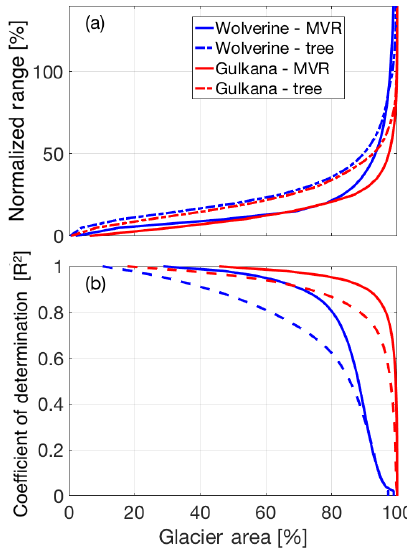
Figure 12. Interannual variability of the SWE accumulation pattern as a function of cumulative glacier area, shown as (a) normalized range and (b) and R 2 . Solid lines are for the multivariable regres- sion (MVR) and dashed lines are for the regression